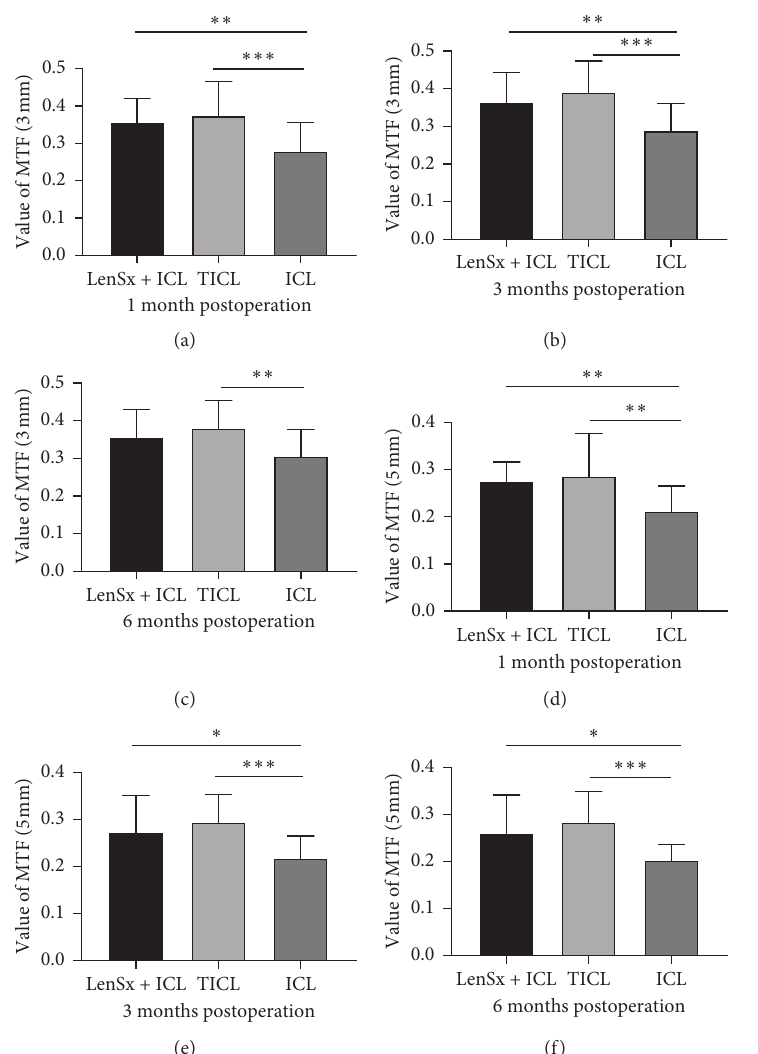
Figure 9: The comparison of modulation transfer function values among three groups after surgery at 1, 3, and 6 months at pupil diameters of 3mm and 5 mm (the results are expressed as means ± SD, ∗ P < 0 . 05, ∗∗ P < 0 . 01, and ∗∗∗ P < 0 .